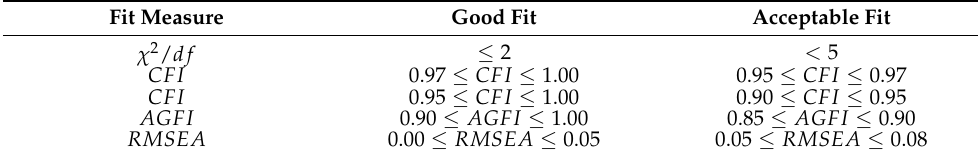
Table 4. Recommendations for some rule-of-thumb criteria for goodness-of-fit indices.